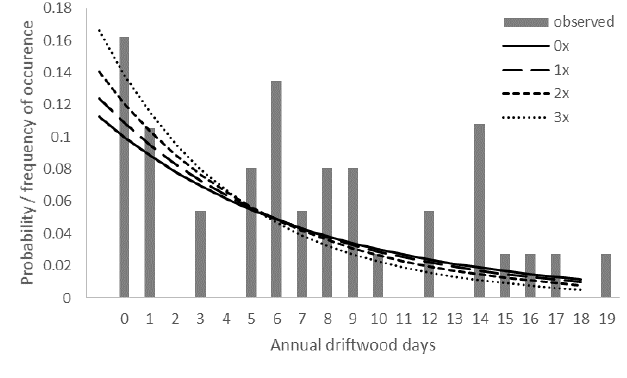
Fig. 5 . The observed frequency, for all years, and expected probability of occurrence of the annual number of driftwood days under 4 scenarios, 0x-3x, with increasing variability from the observed